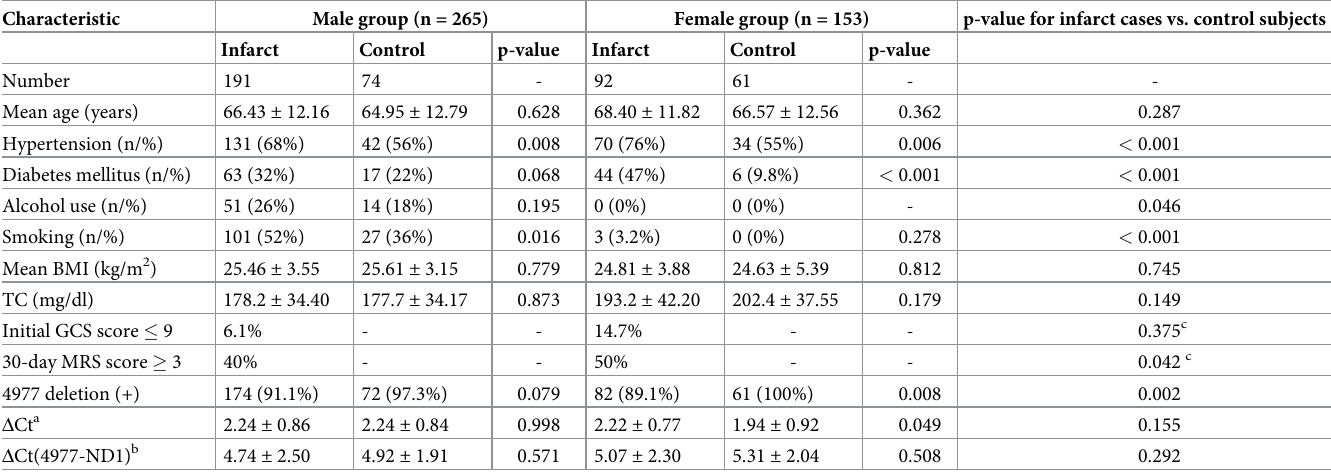
Table 3. Demographic data in patients with ischemic stroke and control subjects.